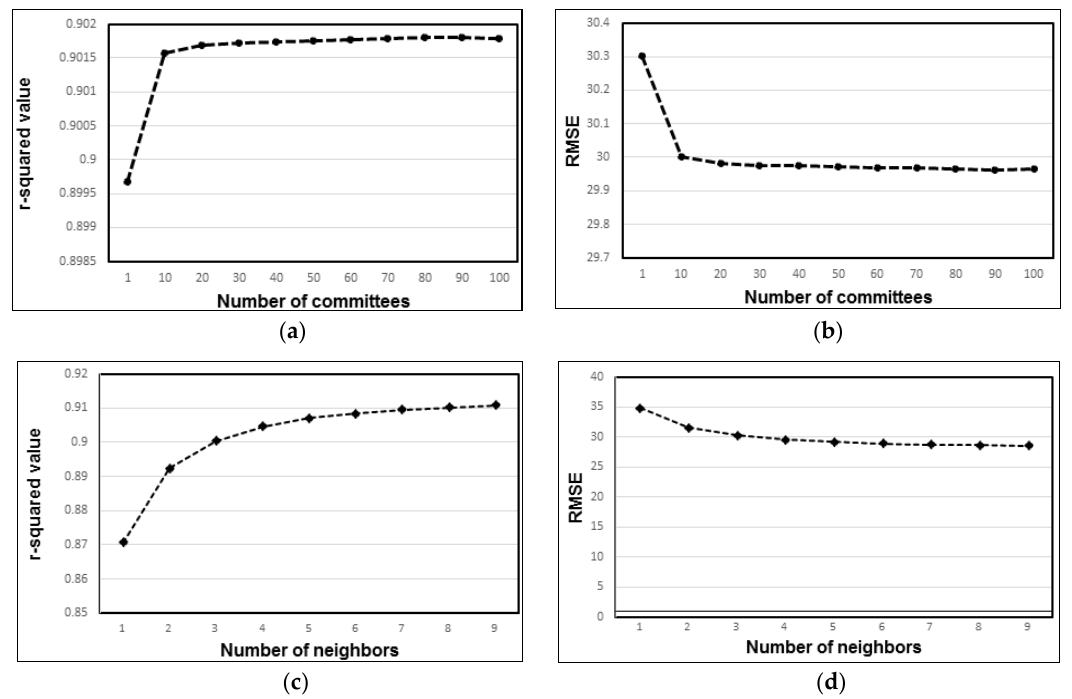
Figure 5. Performance evaluations using ( a ) r-squared values for 1–100 committees; ( b ) Root mean square error (RMSE) for 1–100 committees; ( c ) r-squared values for 1–9 neighbors; ( d ) RMSE for 1–9 neighbors.